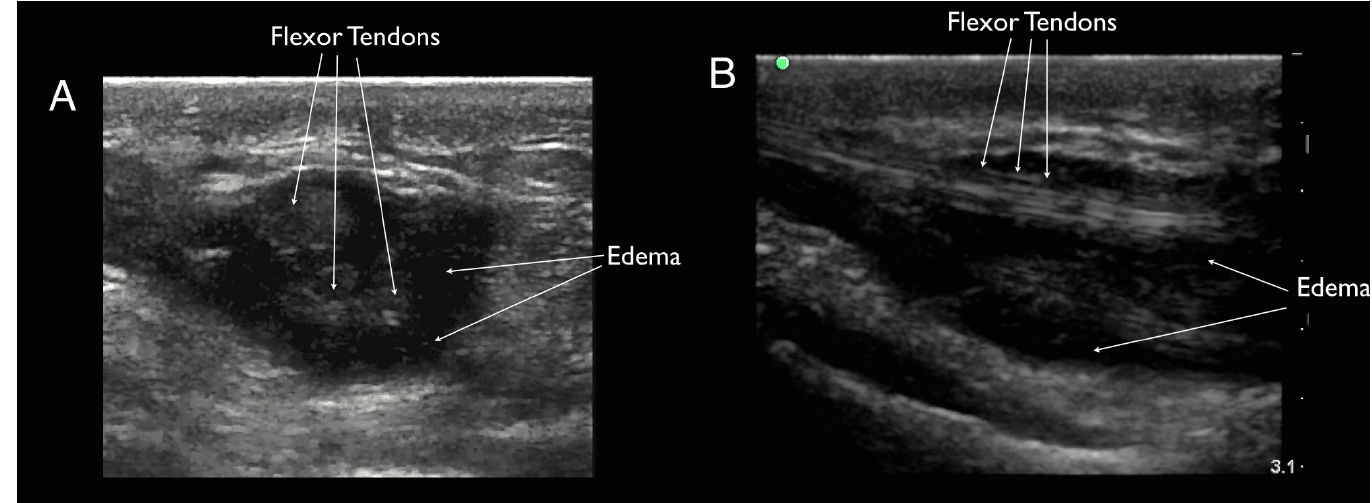
Figure 1 . Ultrasound findings of flexor tenosynovitis. Ultrasound image in transverse view (A) and longitudinal view (B) showing increased anechoic edema and debris in the flexor tendon sheath of the right wrist consistent with flexor tenosynovitis. In the correct clinical scenario, these findings are consistent with the infectious form of flexor tenosynovitis.